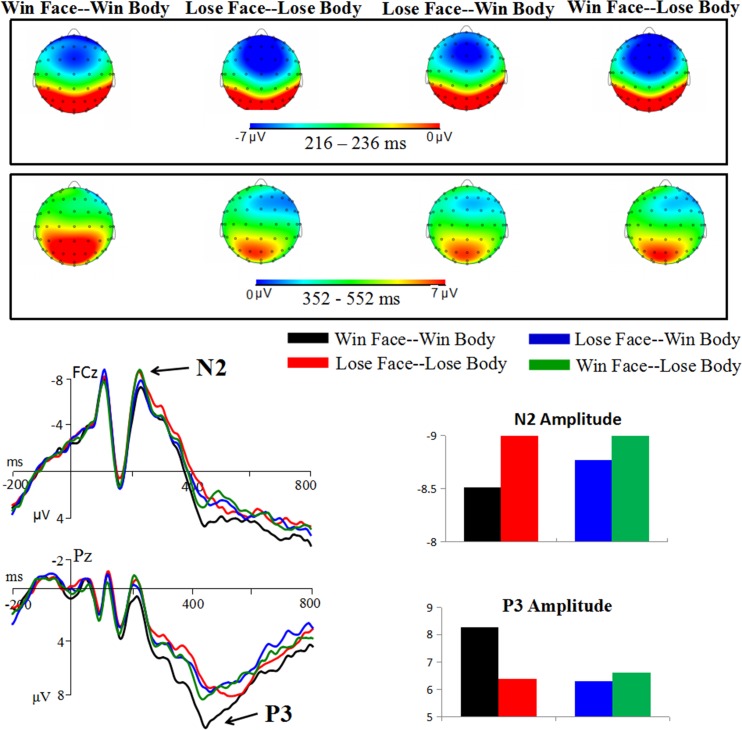
Grand average of the N2 and P3.